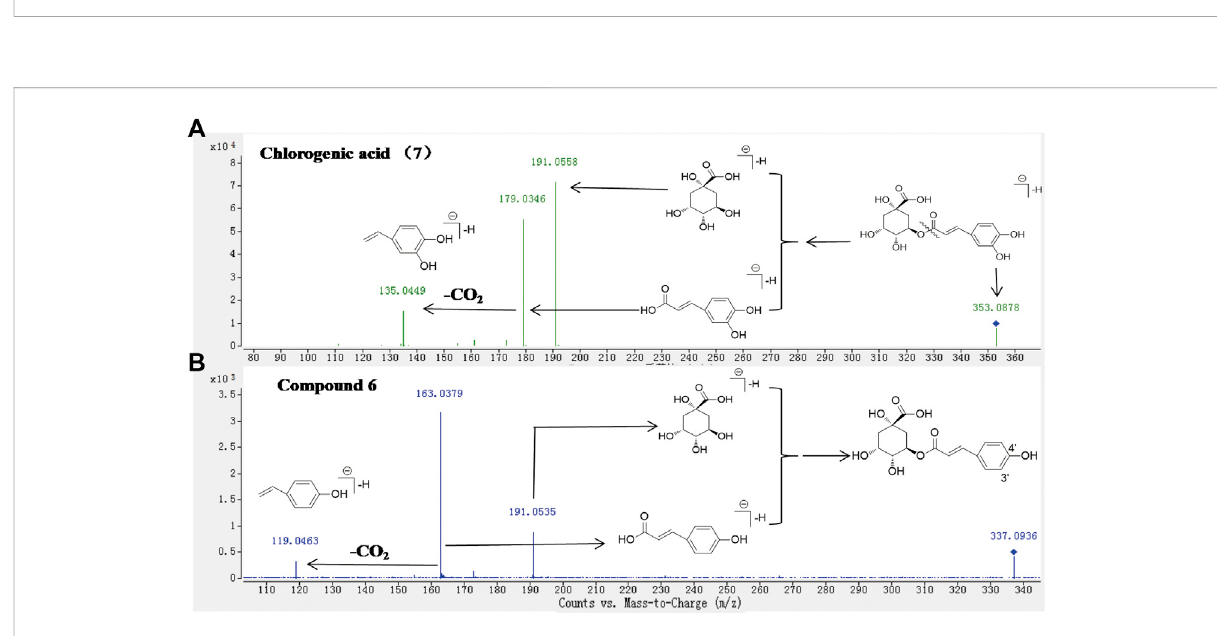
The MS/MS spectra of standard 7 (A) and the metabolite 6 (B) in ESI − mode, and corresponding fragmentation